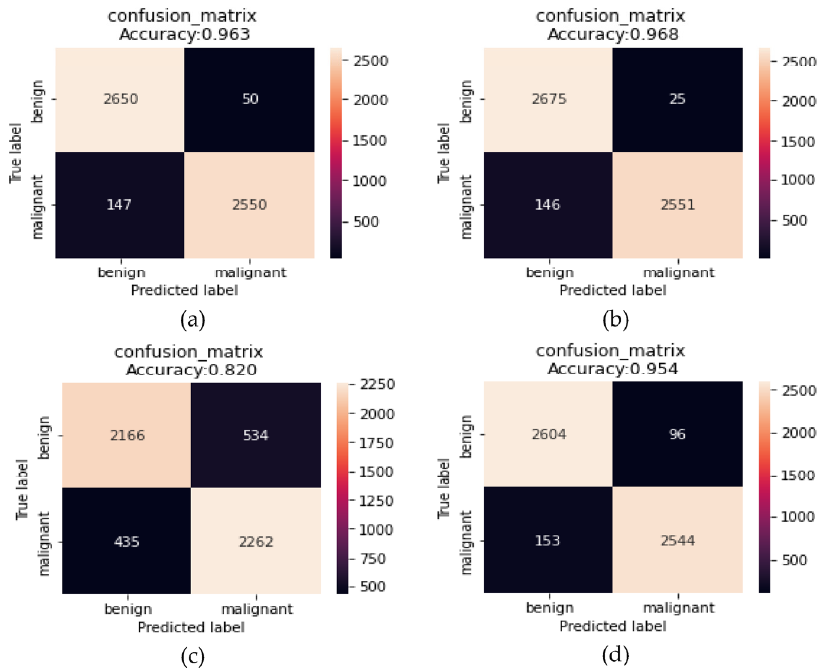
Figure 15. Confusion matrix of the models: ( a ) VGG16; ( b ) Xception; ( c ) ResNet50; ( d ) MobileNetV2 to transfer learning from Scenario2 for skin cancer classification with data augmentation.